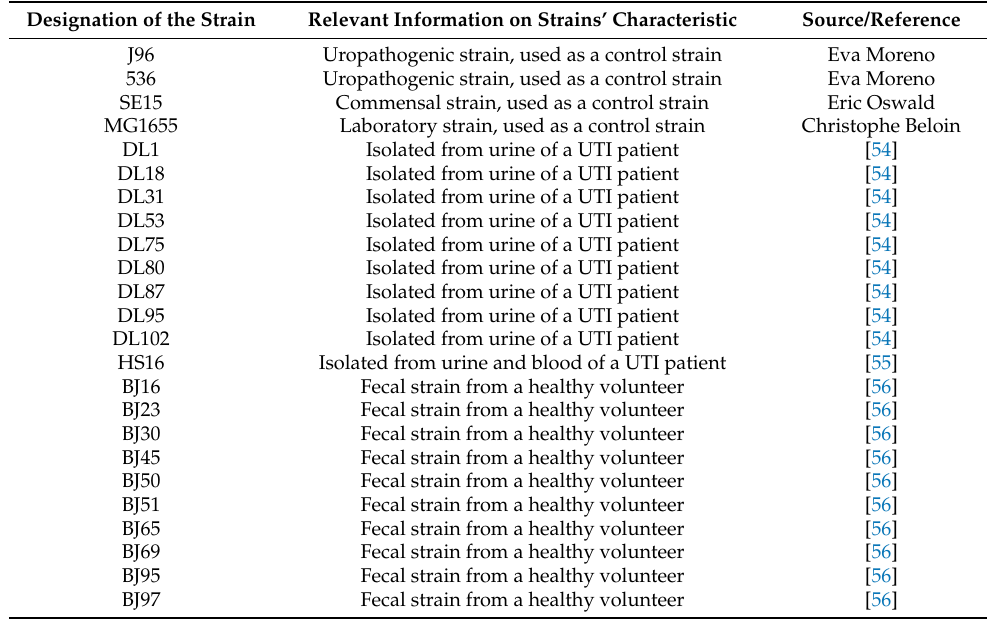
Table 1. Bacterial E. coli strains used in the